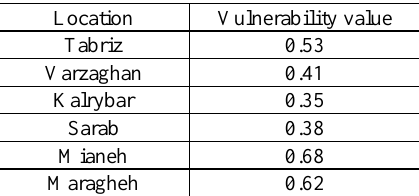
Table 9- Vulnerability values for selected